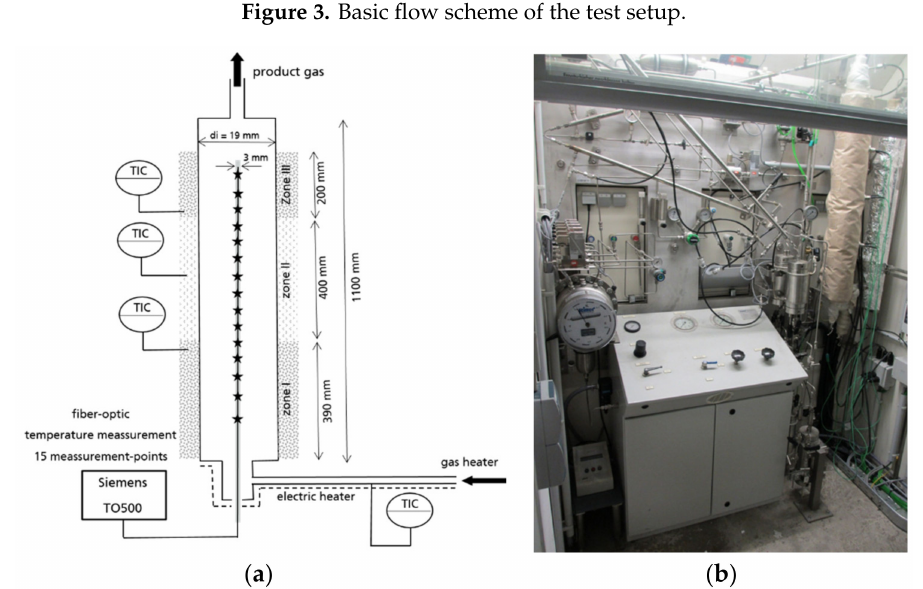
Figure 4. ( a ) Fixed-bed reactor with fibre-optic temperature measurement and ( b ) photo of the test